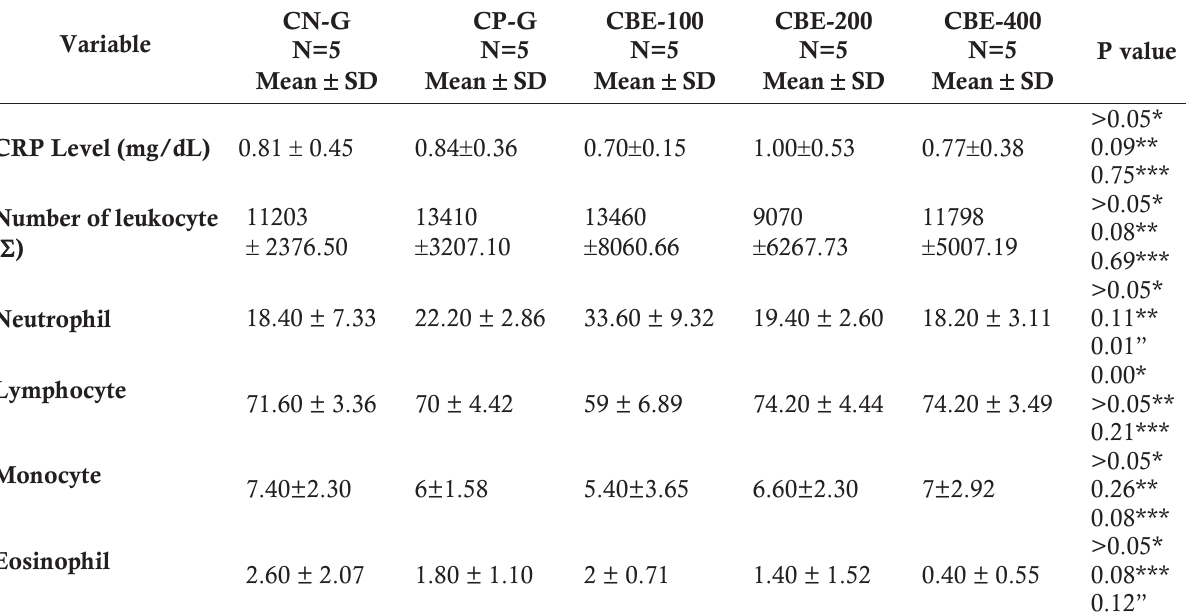
Table 1. Mean of CRP Level, Leukocyte Count and Leukocyte Type Count